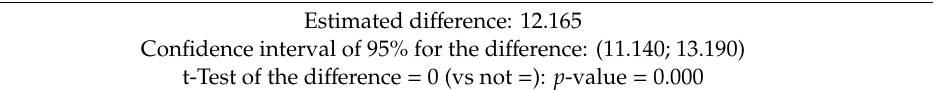
Table 2. Results of two-sample t-test for rotation frequency of current signature .